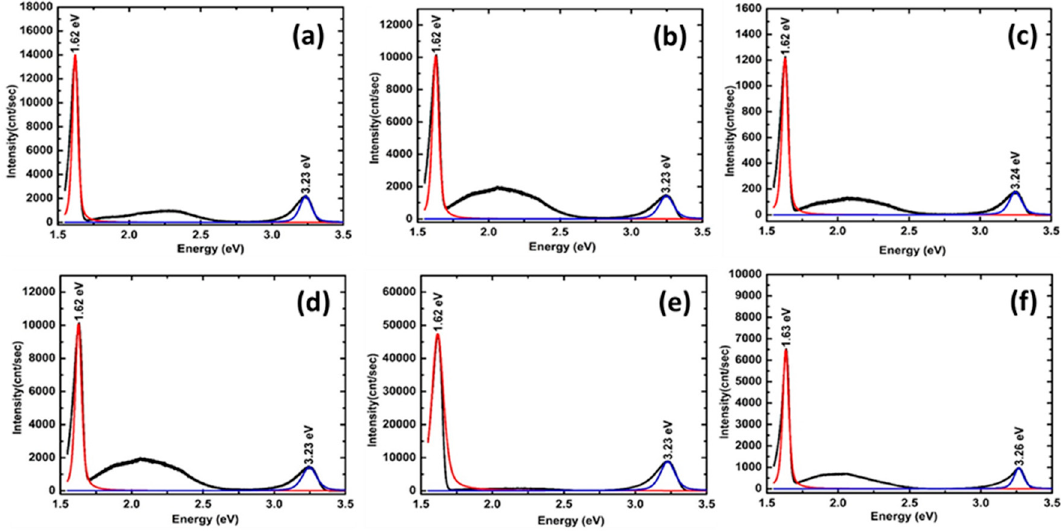
Figure 5. PL spectra of ZnO nanorods grown by using 5000 pulsed laser shots at different temperatures ( a ) 500 °C, ( b ) 550 °C, ( c ) 600 °C and PL spectra of ZnO nanorods grown at 550 °C by varying the number of pulse laser shots ( d ) 5000, ( e ) 10,000, ( f ) 15,000.